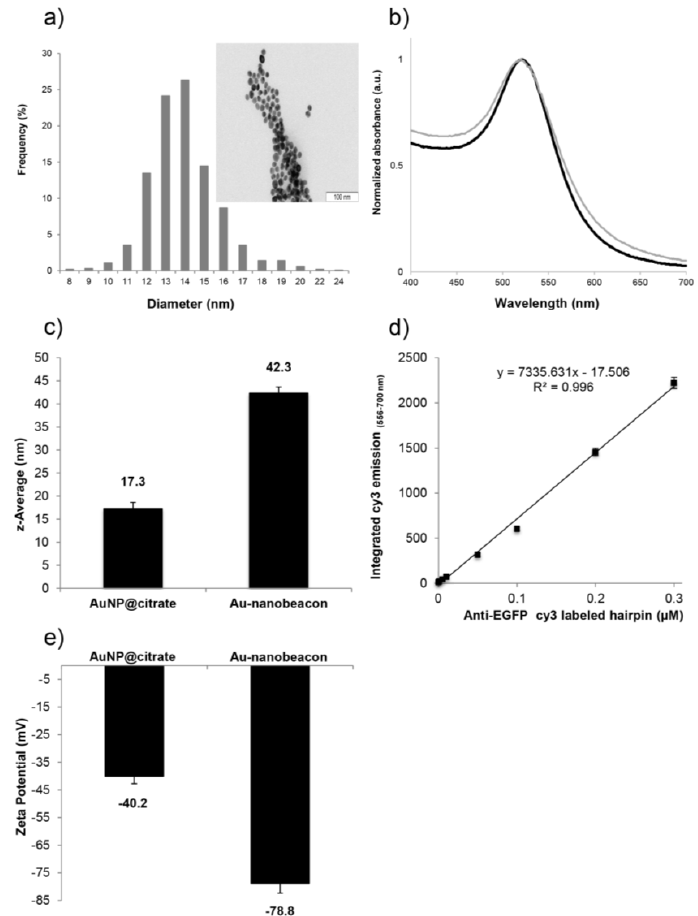
Figure 1. Characterization of the synthesized AuNP@citrate and Au-nanobeacon; ( a ) Size distribution of the synthesized AuNP@citrate, Inset: Transmission electron microscopy (TEM) image of the AuNP@citrate (scale bar: 100 nm); ( b ) Ultra-violet (UV)-Vis spectra of the AuNP@citrate (solid black line) and Au-nanobeacon (solid grey line); ( c ) Hydrodynamic diameter of AuNP@citrate and Au-nanobeacon; ( d ) Calibration curve for the quantification of the number of hairpins per PEGylated AuNPs; ( e ) Zeta potential of AuNP@citrate and Au-nanobeacon.